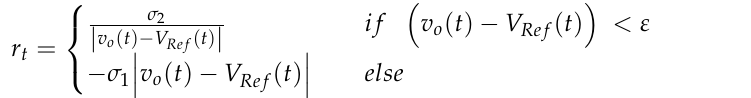
Figure 5. Structure of MF-NIB controller designed by the DDPG algorithm.